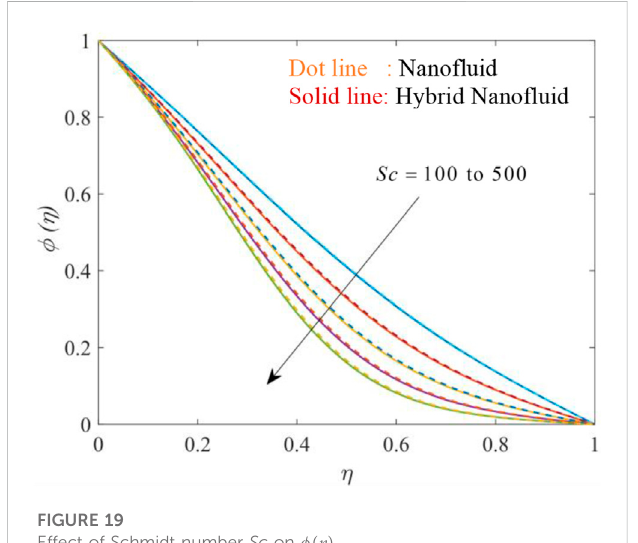
FIGURE 20 Effect of nanoparticles volume fraction ϕ on φ ( η )